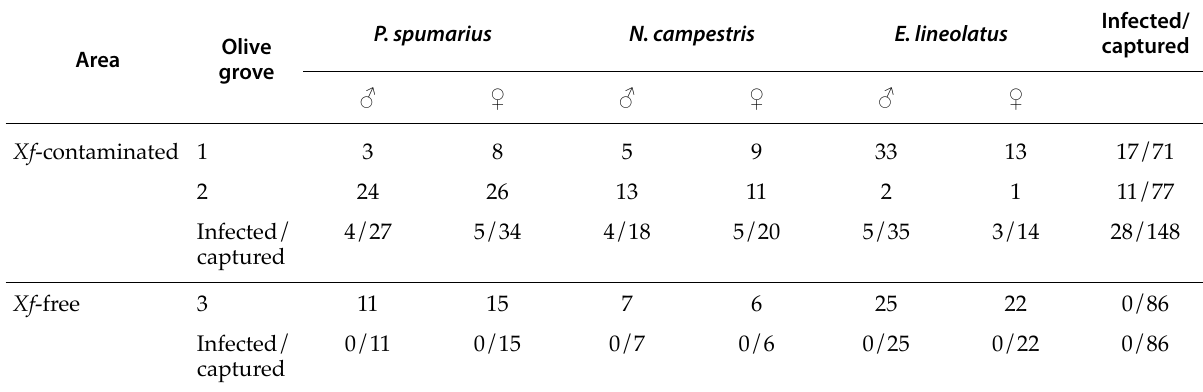
Table 2. Number of Auchenorrhyncha insects (males and females) captured from two Xf- infected olive orchards and one non-infected olive orchard.